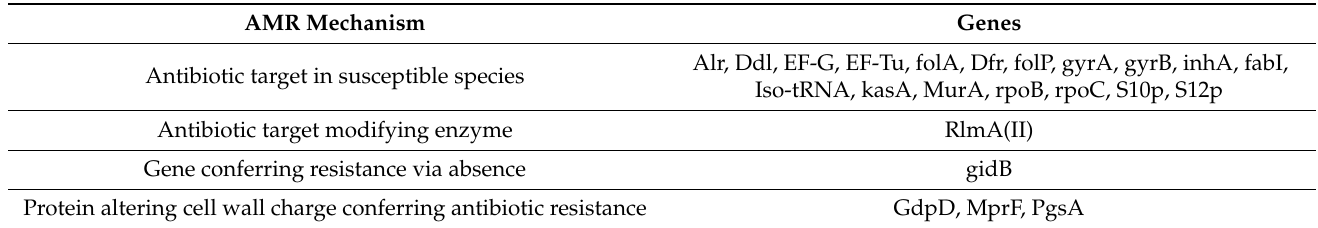
Table 3. Antimicrobial resistance (AMR) genes according to the Genome Annotation Service in